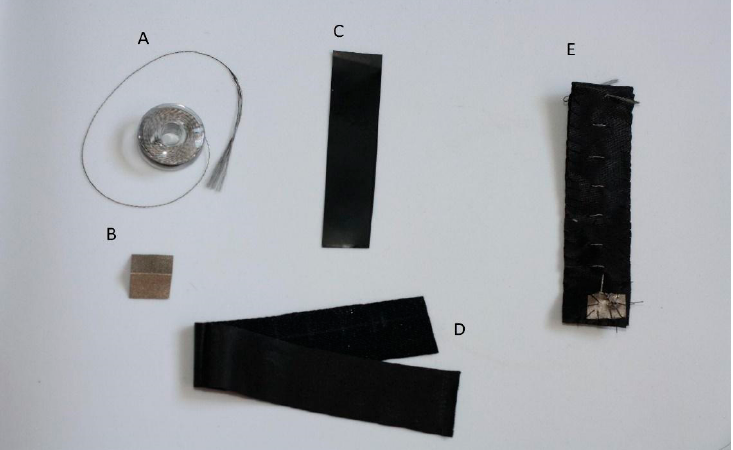
Figure 2. Prototype of a glove for translating sign language.